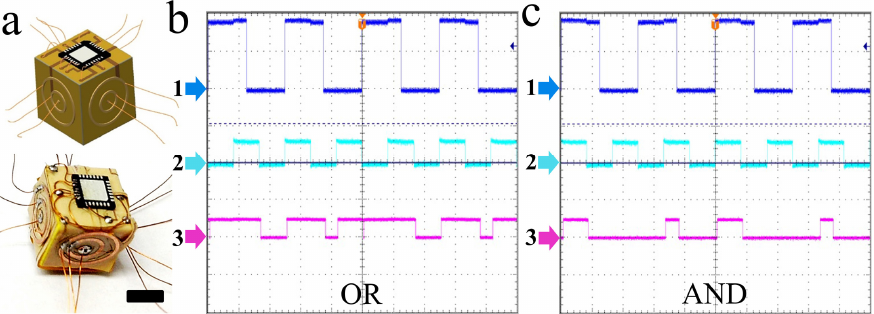
Figure 6. Verification of functionality of a monomer E-block. ( a ) Schematic and optical images of a wired E-block monomer. The scale bar indicates 5 mm; ( b , c ) experimentally recorded oscilloscope readings show the output of the monomer configured as ( b ) OR gate and ( c ) AND gate. 1 and 2 represent inputs and 3 is the output.